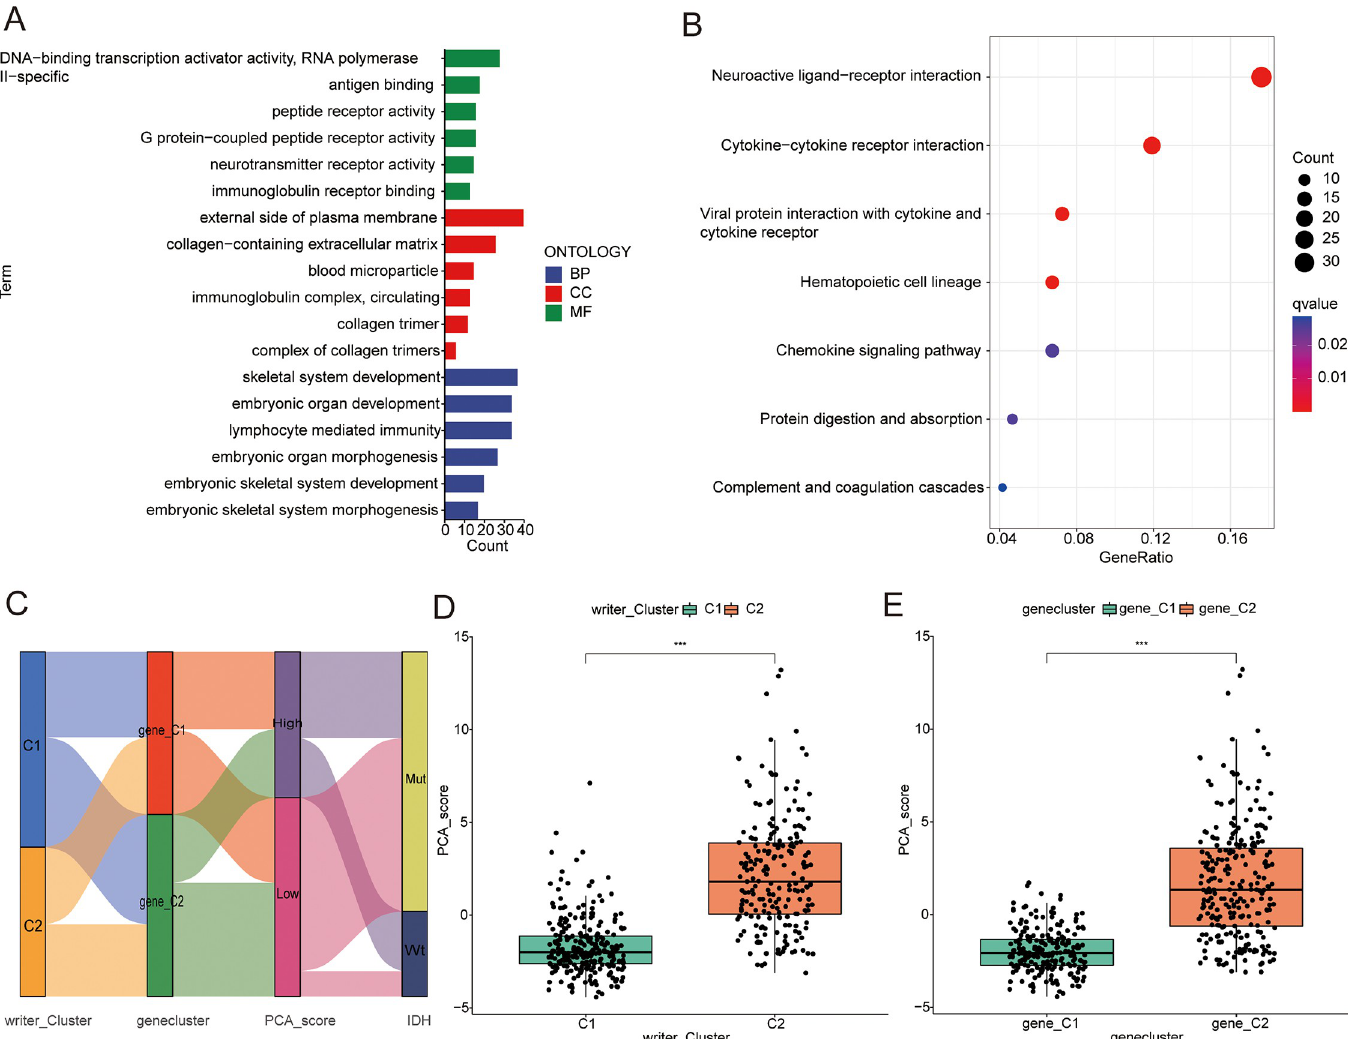
Fig 4. Identification of gene subtypes based on DEGs. (A and B) GO and KEGG enrichment analyses of DEGs among two RNA modification "writer" molecular subtypes. (C) Alluvial diagram of subtype distributions in groups with different PCA_score and IDH mutation. (D) Differences in PCA_score between two